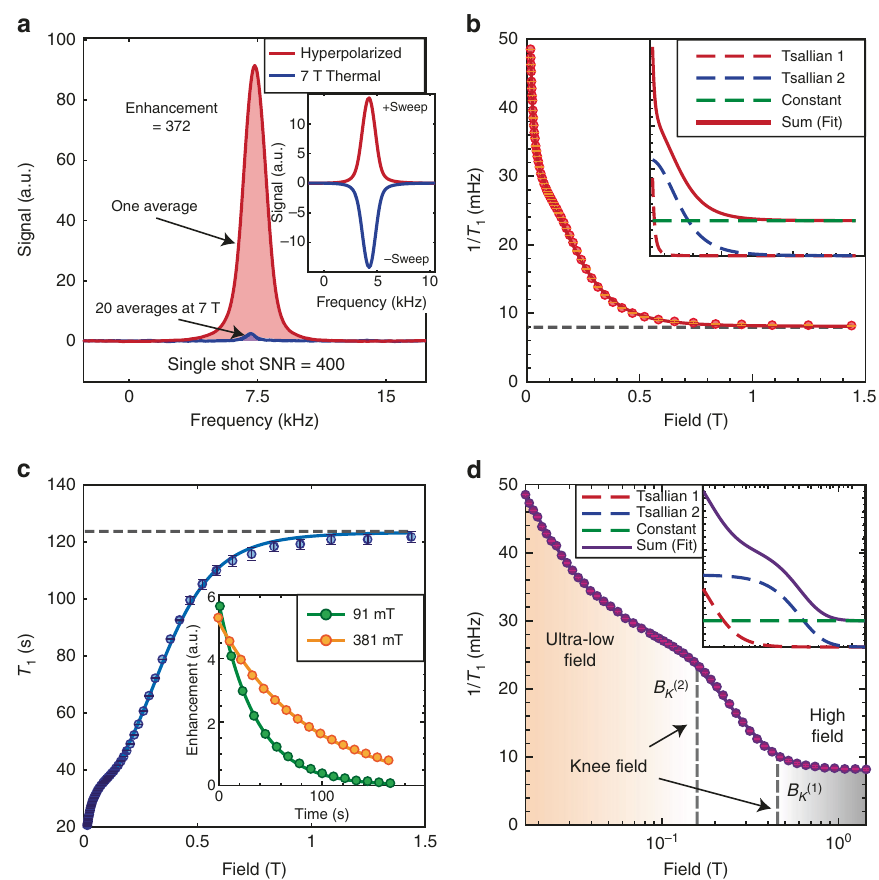
Fig. 2 Hyperpolarized relaxometry applied to a 10% 13 C -enriched single crystal (sample 6 in Table 1). a Signal gains due to hyperpolarization under optimal conditions at B 36 mT. Red line shows a single-shot hyperpolarized signal (SNR (cid:5) 400) after 60 s of optical pumping. Blue line is the 7 T thermal pol (cid:5) signal after 20 averages, allowing us to quantify signal enhancement from DNP (cid:5) 372 over 7 T, a time saving by (cid:5) 10 6 for equal SNR. Inset: Exemplary signals at B 36 mT under low-to-high (high-to-low) frequency sweeps leading to positive (negative) 13 C hyperpolarization. b Relaxation rate R 1 ¼ 1 = T 1 pol (cid:5) obtained from relaxometry over a wide- fi eld range 20 mT – 1.5 T. We observe a rapid growth in relaxation rate below a knee fi eld of 0.5 T, and saturation at higher fi elds. Inset: Data can be fi t to two Tsallian functions, which we ascribe to be originating from inter- 13 C couplings and interactions to the P1 spin bath. c Spin lifetimes as a function of fi eld, showing signi fi cant boost in nuclear T 1 beyond the knee fi eld, approaching a lifetime (cid:5) 2.1 min. Inset: Typical relaxation data at two representative fi elds showing monoexponential character. d Logarithmic scale data visualization, displaying a more equanimous sampling of experimental points, and the knee fi elds in fl ection points B ð 1 ; 2 Þ K . Inset: Decomposition into the constituent Tsallians. Error bars in all panels are obtained from monoexponential fi ts.